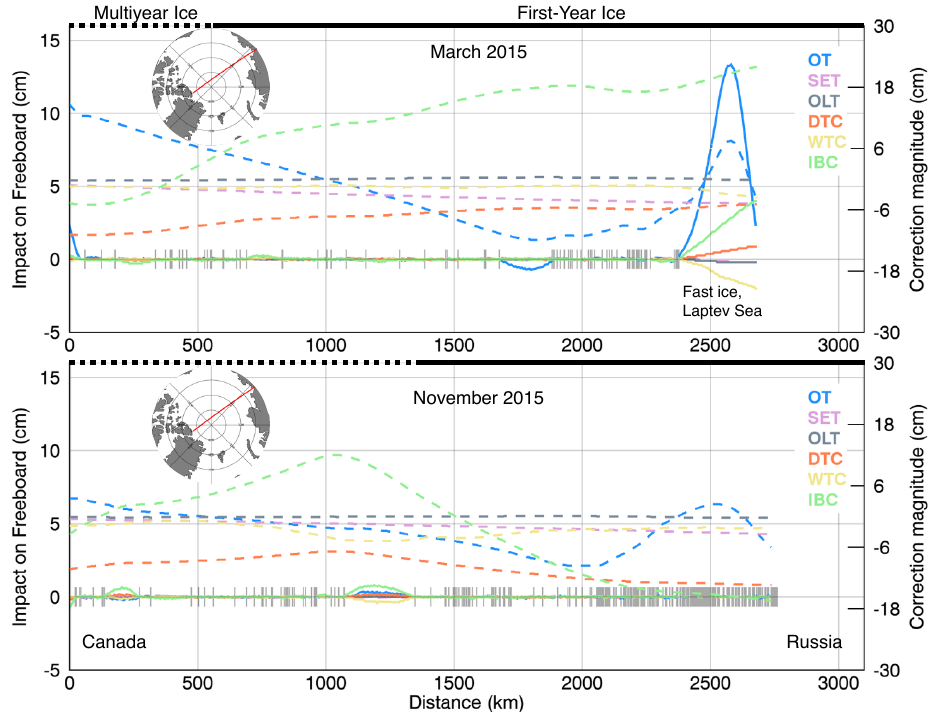
Figure 3. The impact of geophysical corrections on the CryoSat-2 freeboard of a single orbit segment (solid lines), which starts in Lincoln Sea north of Canada over multiyear ice and ends over fast ice in the Laptev Sea. The explanation for the acronyms can be found in Table 1. The corresponding dashed lines (right axis) represent the absolute corrections, that are applied. Note, that we increased DTC by 2.2 m to make it visible in this plot (see Figure 1b). The vertical grey lines flag detected leads in the ice cover. The black dashed and solid lines on the top flag the first-year ice and multiyear ice regimes along